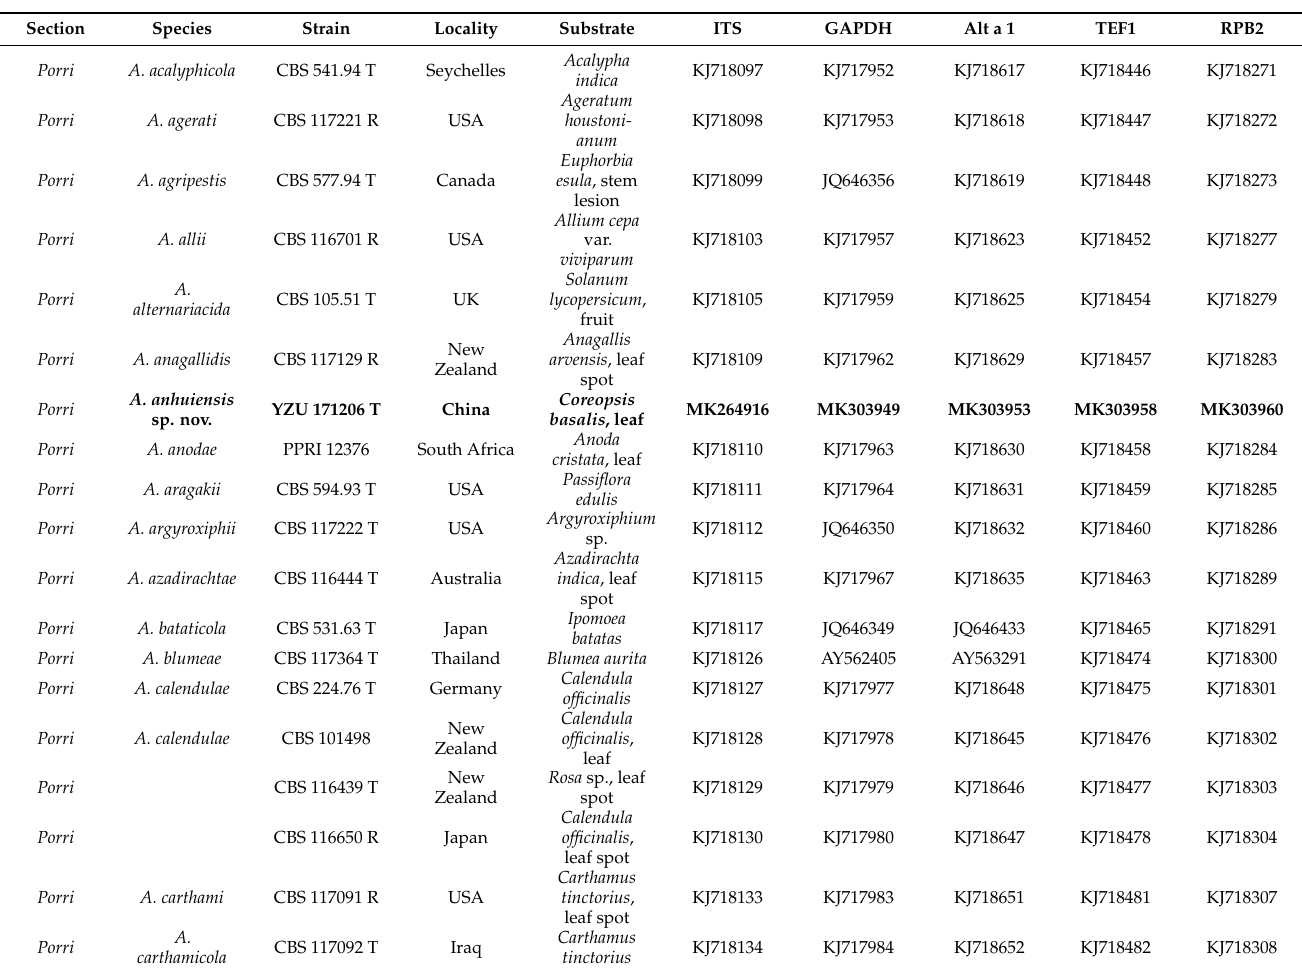
BS/posterior probability-PP) were indicated in the phylogram. Alternaria gypsophilae CBS 107.41 in sect. Gypsophilae was used as an outgroup. Table 1. GenBank accession numbers of Alternaria species used in phylogenetic